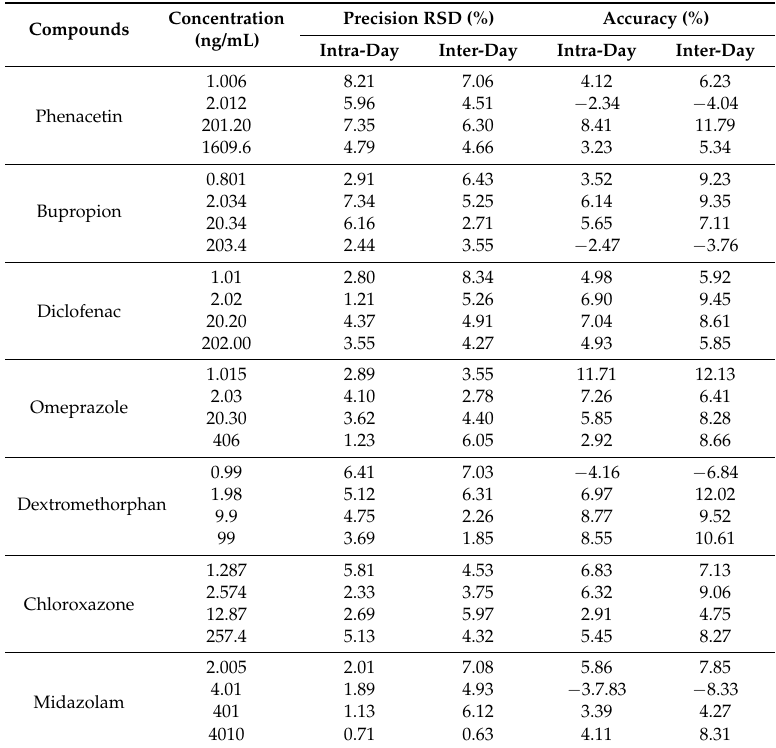
Table 2. Intra- and inter-day precision and accuracy values for probe drugs in rat plasma at LLOQ, low, medium and high concentrations ( n = 6).